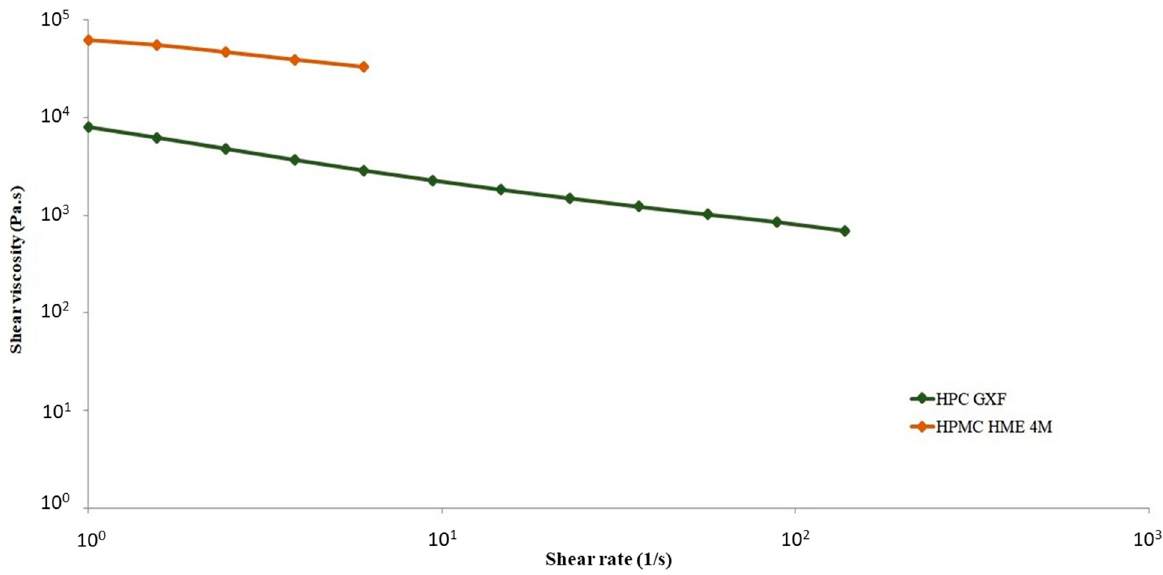
Figure 8. Steady-shear viscosity of the HPMC HME 4M and HPC GXF at a temperature of 160 °C as measured using a capillary rheometer. Both polymers are shear thinning, indicating that the melt granulation process can be improved by increasing the shear rate inside the extruder.